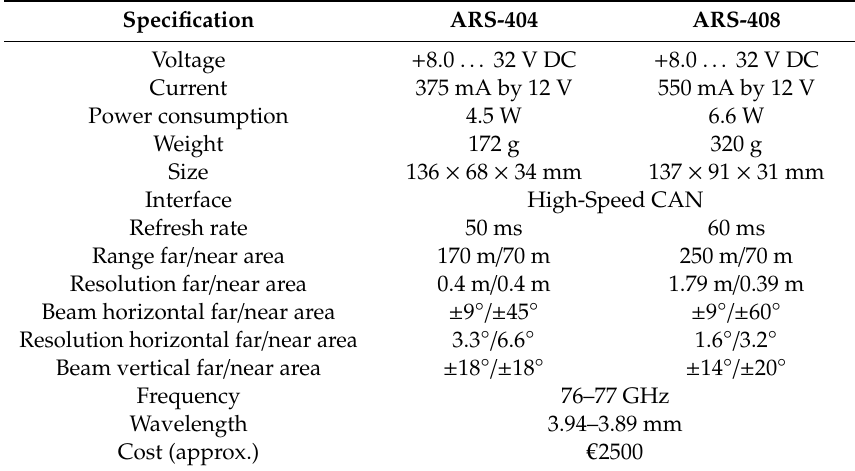
Table 1. Specifications of the ARS-404 and ARS-408 radar sensors [49].